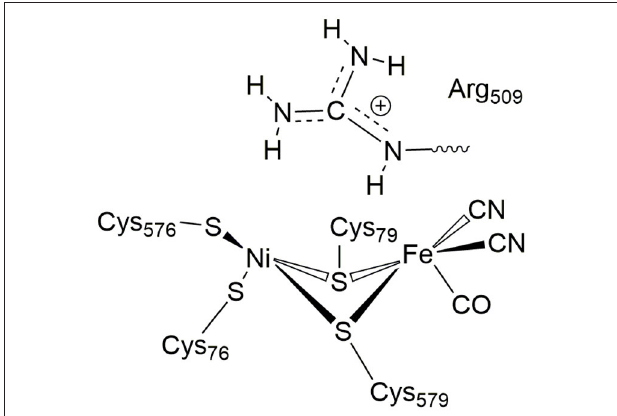
FIGURE 2 | Positioning of a strictly conserved second coordination shell arginine amino acid residue (Arg 509 ) above the active site of [NiFe]-hydrogenases (using the amino acid numbering of the [NiFe]-hydrogenase from E. coli